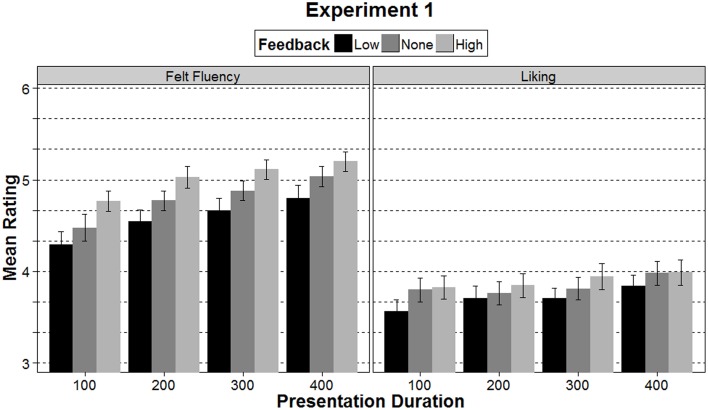
Mean ratings of felt fluency and liking in Experiment 1 separately for the three feedback conditions and the four presentation durations. Error bars represent ±1 SE.